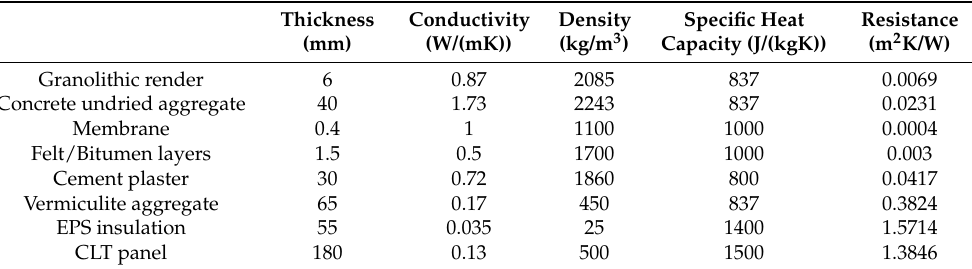
Table 6. Details of CLT roof design in Beijing.